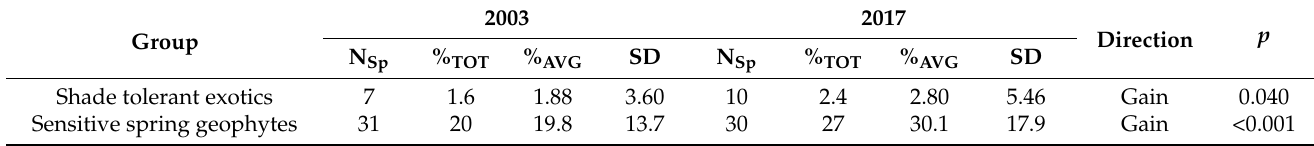
Table 6. Comparison of average values and standard deviation (SD) of the relative proportion in stand total occurrences (% AVG ), for shade tolerant exotics (Q3) and sensitive spring geophytes (Q4) between the 2003 and 2017 understory communities inventories ( N = 20). Statistics of the Wilcoxon paired t -test (direction of changes and associated p -value) are also included, as well as the number of species (N Sp ) in each group and their relative proportion in the total vegetation across stands (i.e., all 20 study sites combined; % TOT ) for both years (see Tables S2/S3 for species list).